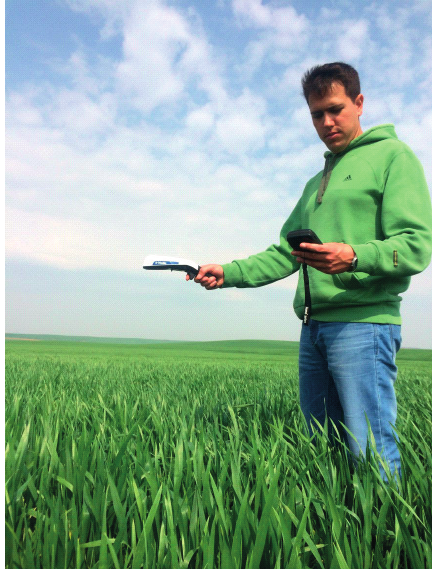
Figure 1. Hand-held NDVI sampling system in the experimental